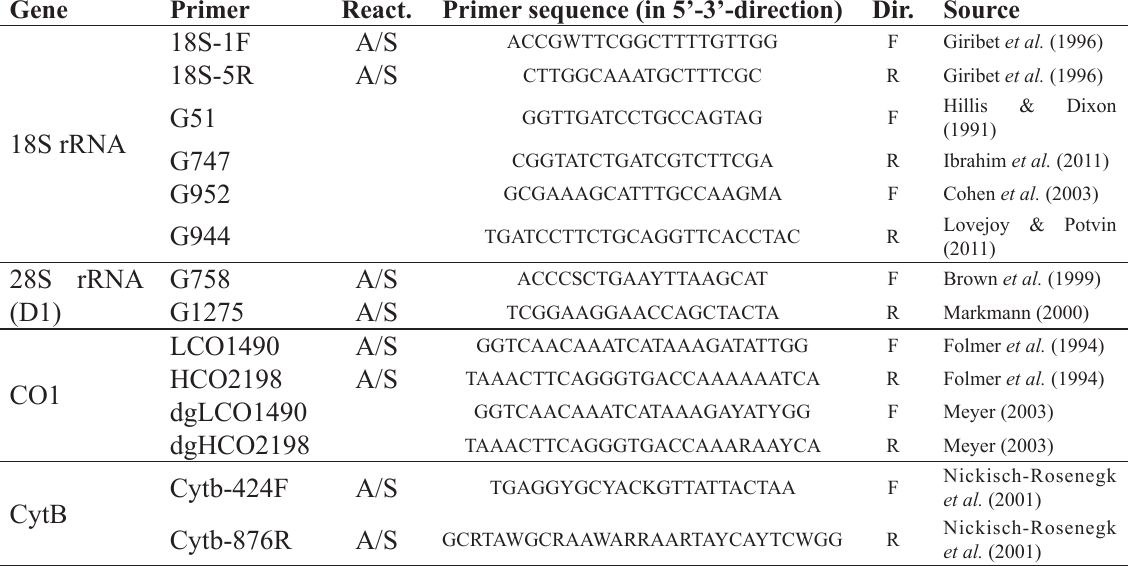
Table 2 . List of primers used for amplification and sequencing, with original references. Gene